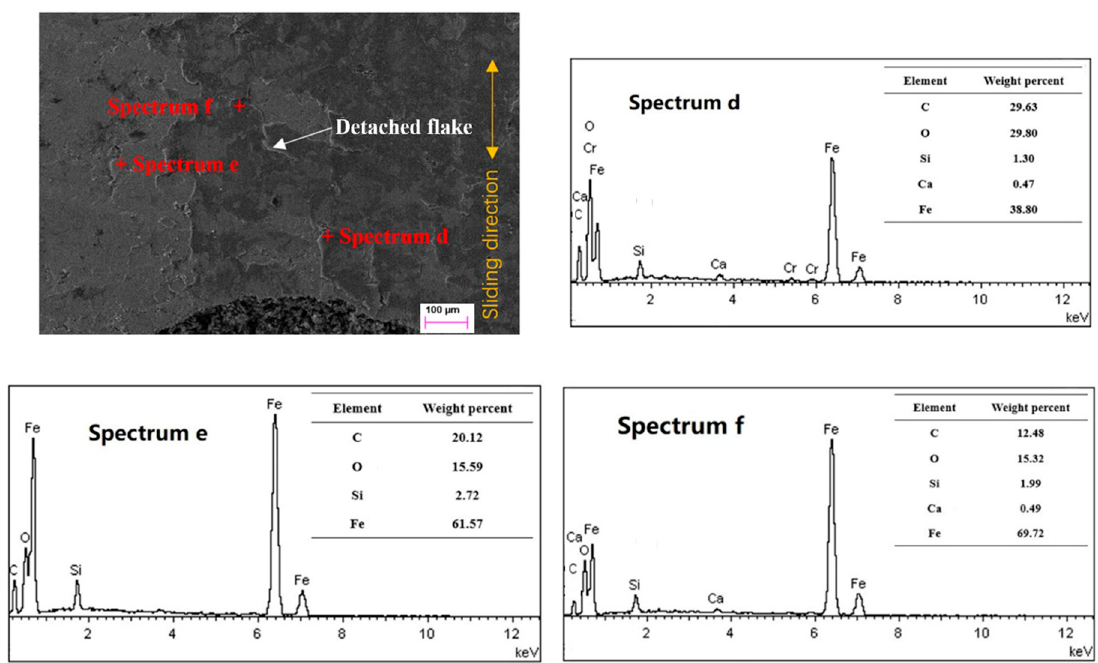
Figure 12. Topography and element composition on the left part of the micro-dimpled surface before scuffing.